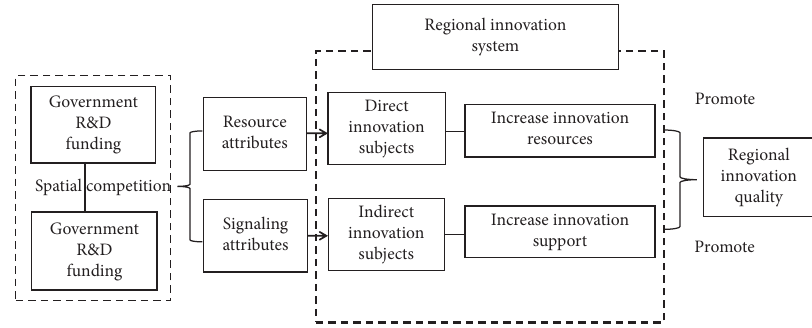
Figure 1: Framework of theoretical